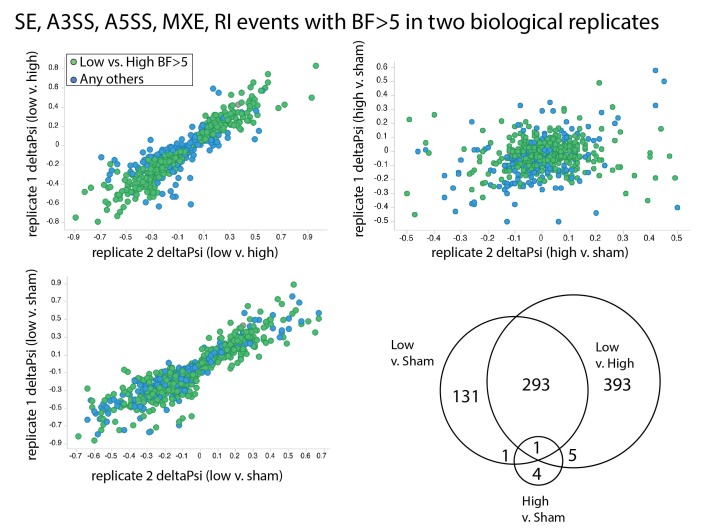
Splicing changes are primarily induced by low flow rather than high flow.Comparison of the change in inclusion frequency by MISO for individual splicing events of the SE, MXE, A3SS, A5SS and RI classes. In green are the events presented in Figure 1C. In blue are all other events with BF >5 in two independent biological comparisons of low flow versus sham, or with BF >5 in two independent biological comparisons of high flow versus sham. Then Venn diagram shows the overlap in these events found to be significant in each of the independent comparisons.